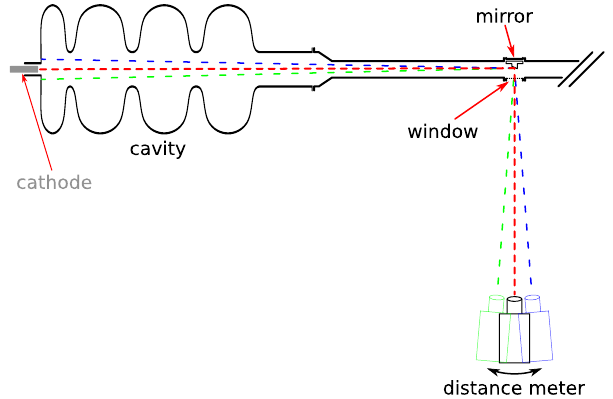
FIG. 4. Scheme of the experimental setup of the cathode localization: The laser driven distance meter uses the same mirror, which is used to shine UV light on the photocathode during operation, to scan the cathode tip with respect to the half cell ’ s back plate.